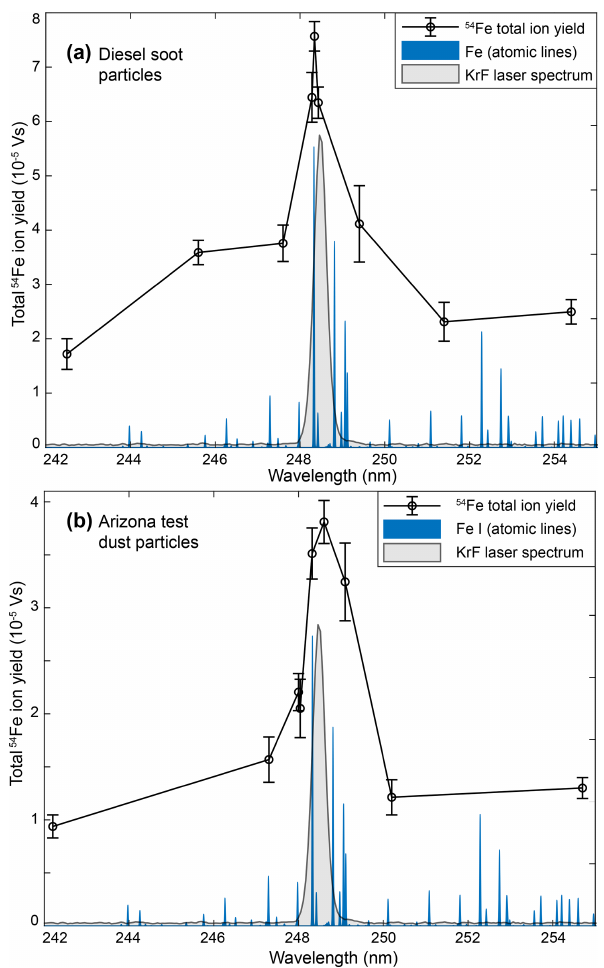
Figure 2. Wavelength-dependent total ion yield of 54 Fe in SPMS of re-dispersed particles (black circles, n = 1200; three replicates of 400 each). For both (a) diesel soot particles and (b) Arizona desert dust particles, the signal peaks for wavelengths match a ma- jor atomic transition of Fe (blue lines). The large width of the curve is attributed to line broadening through interaction with the dense particle surface. Coincidentally, the Fe lines are also addressed by our KrF-excimer laser (measured spectrum in grey; arbitrary units). Atomic spectra from the NIST library (Kramida et al., 2019). Mass spectra are shown in Fig. 1, the respective curves of the normalized ion signals and size distributions are given in Fig.